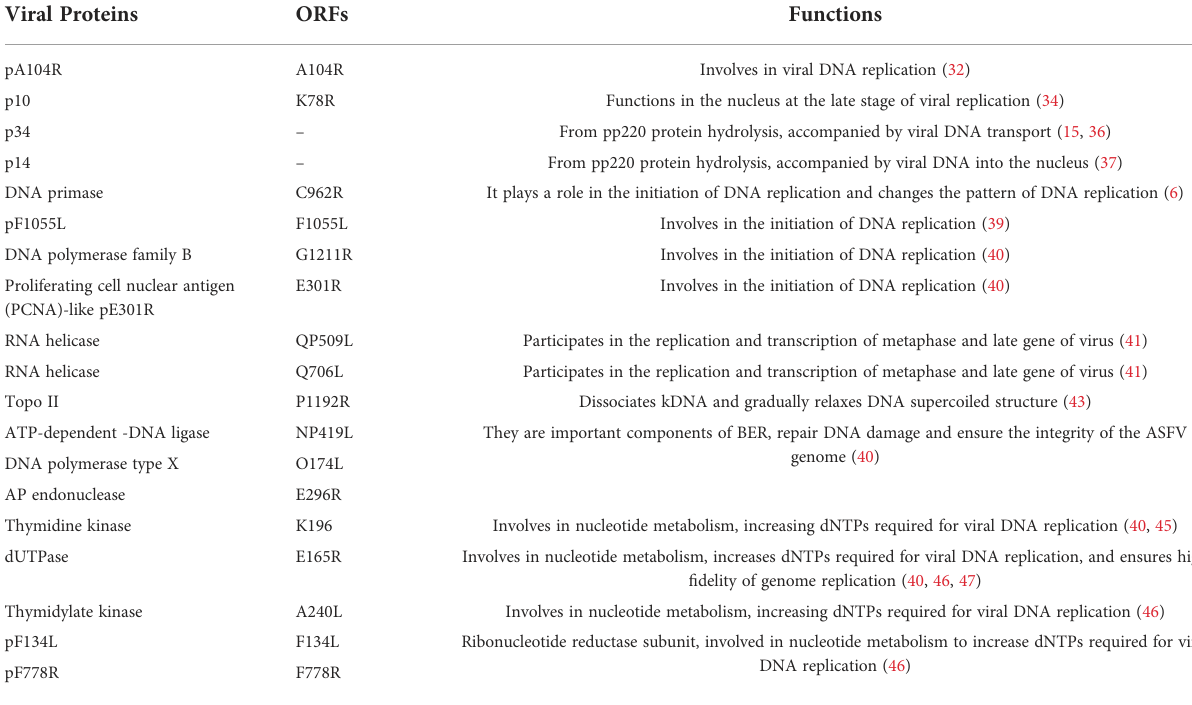
TABLE 2 ASFV encodes related proteins involved in the genome duplication